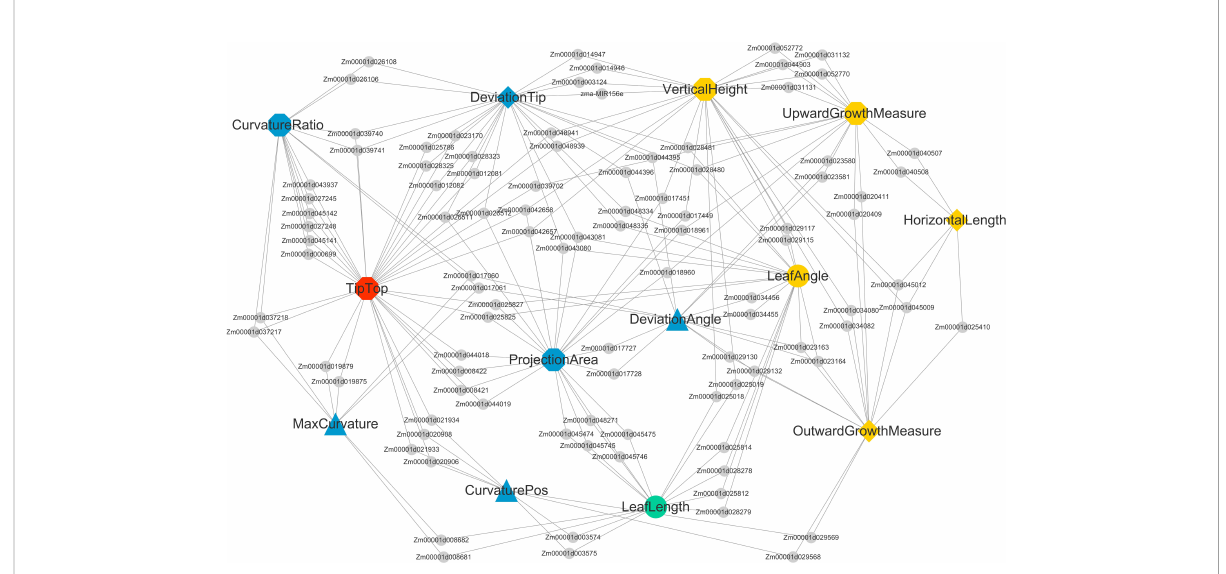
FIGURE 10 Shared candidate genes among 13 traits of maize ear leaf midrib curves. Traits and genes are shown in different shapes and sizes. Of the 13 large nodes, traits of different dimensions are represented by different colors and shapes. Candidate genes are represented by the small gray circular